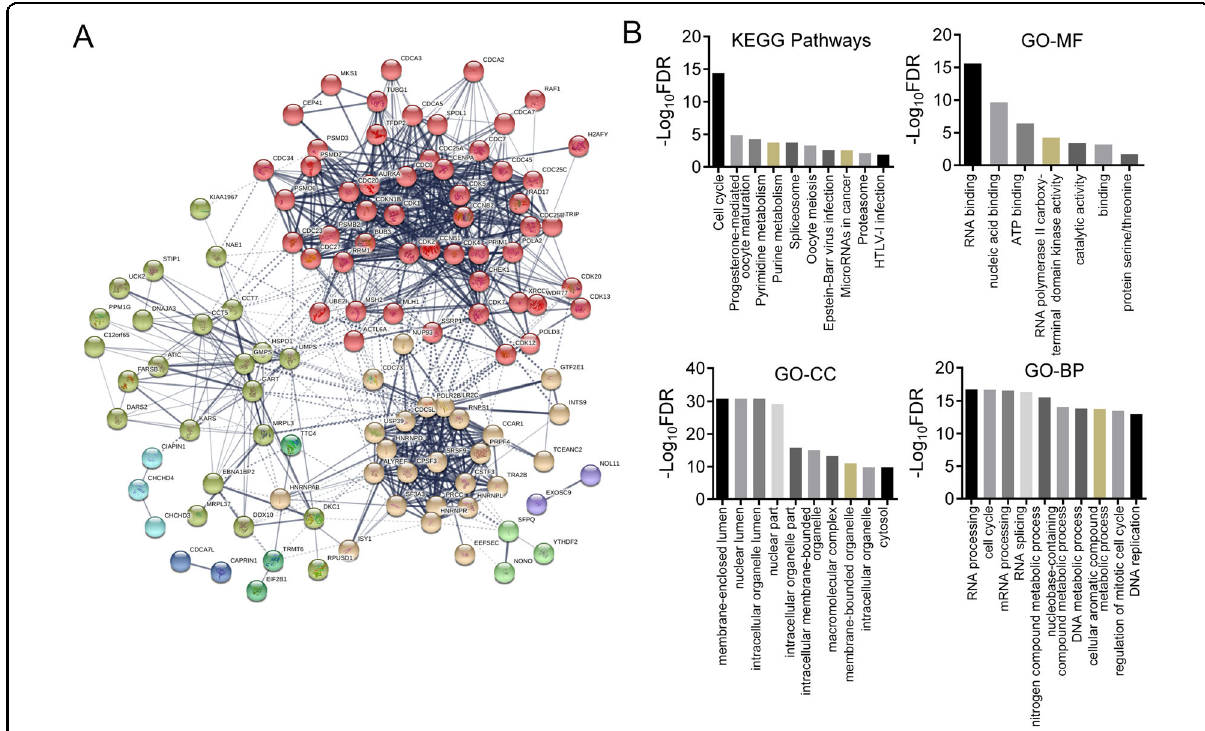
Fig. 2 Pontin co-expressed gene network indicates the involvement of Pontin in cell cycle and RNA processing regulations. A Protein – protein interaction network of Pontin co-expressed genes in GBM screened by cBioportal and depicted by STRING. B KEGG pathway and GO enrichment (MF molecular function, CC cellular component, BP biological process) analyses of Pontin co-expressed genes by STRING. – Log 10 transformed false discovery rates (FDR) are plotted for each enriched functional